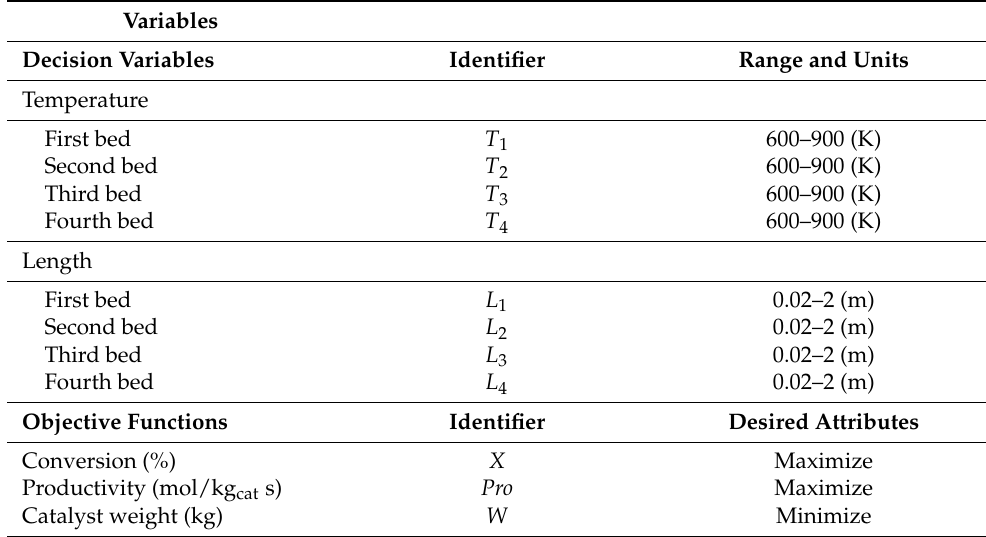
Table 4. Input and output process